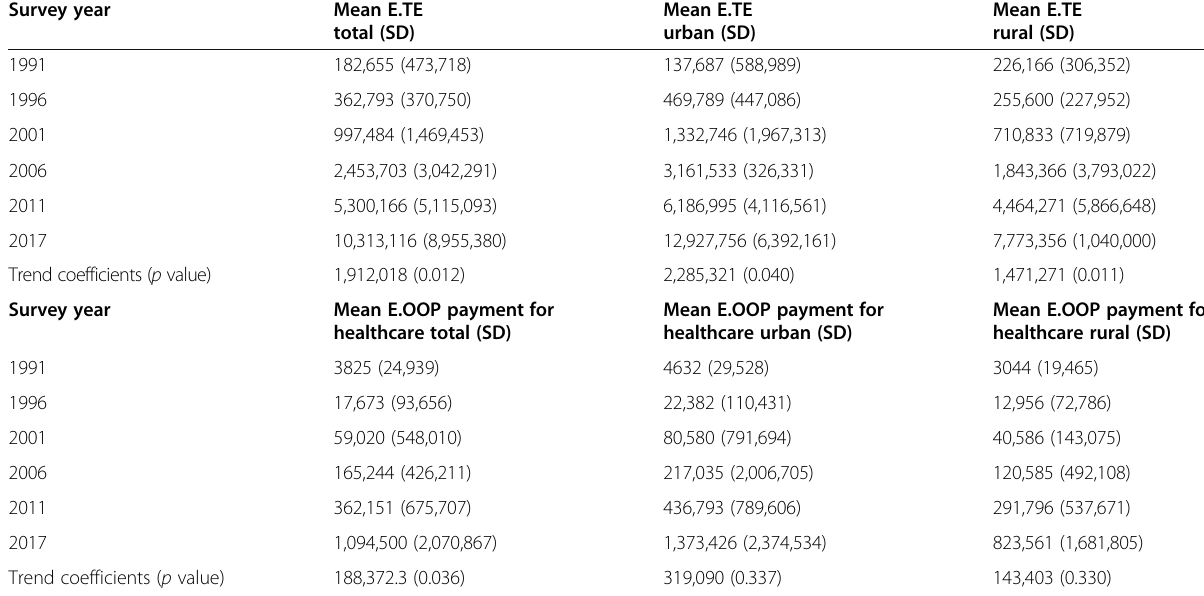
Table 1 Mean equivalized TE and OOP payment for health care of the total, urban, and rural households over 6 years in Iran Survey